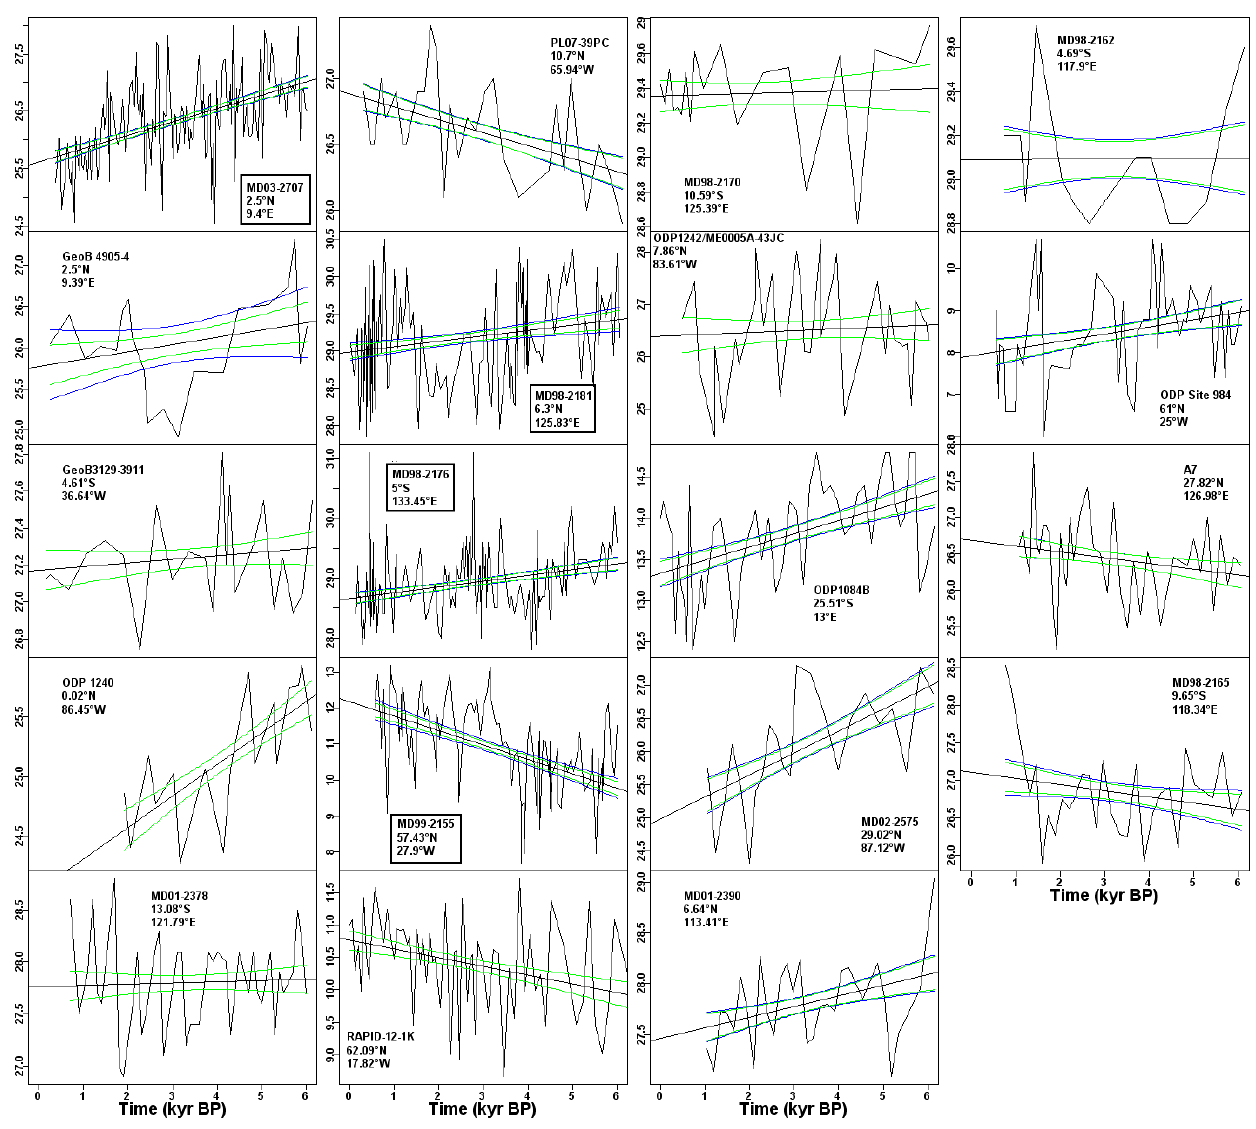
Fig. 4. As Fig. 1, but for Mg/Ca